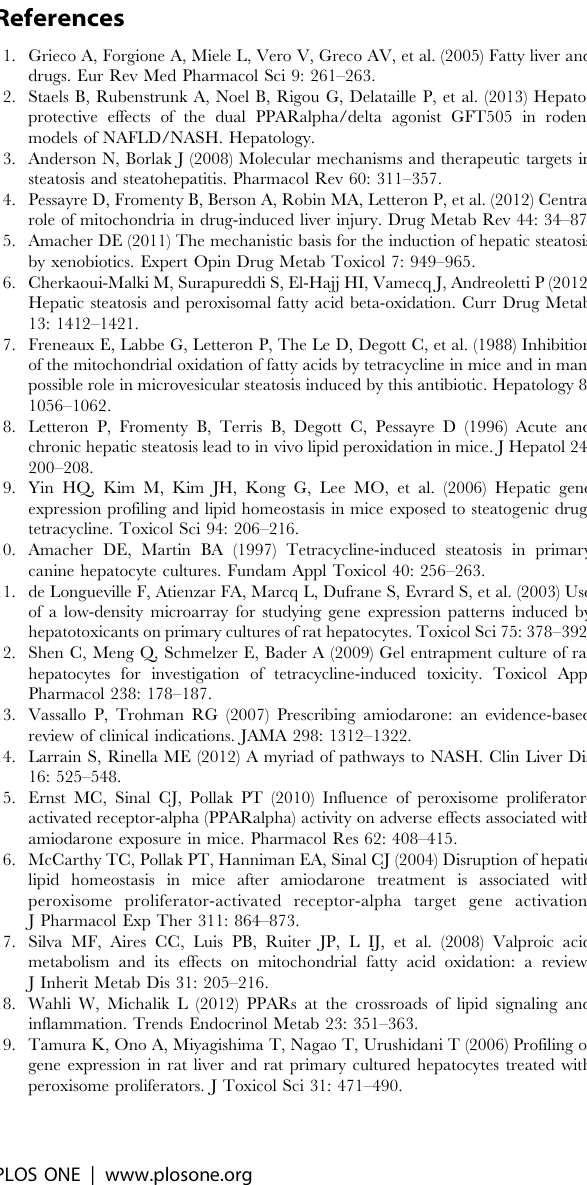
Table S2 Total GO analysis. Significant genes altered by steatogenic drugs in precision cut liver slices (PCLS) were subjected to Gene Ontology (GO) analysis in DAVID. The GO analysis identified 288 (27 up- and 261-down-regulated), 152 (18 up- and 136 down-regulated), and 21 (downregulated) GO terms for amiodarone, valproic acid, and tetracycline respectively. Table S3 Candidate biomarkers. Functions of candidate biomarkers for PPAR agonists and tetracycline (TET)-like acting compounds are derived from GeneCards